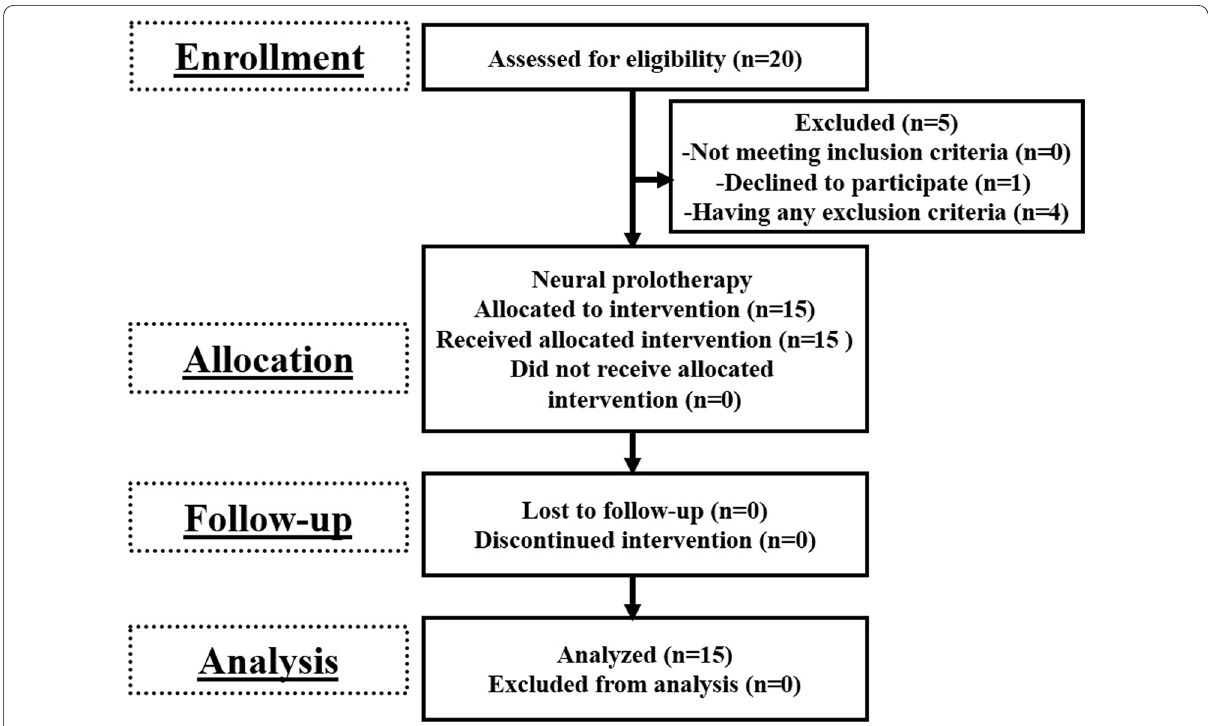
Fig. 1 The study flowchart. n , number of